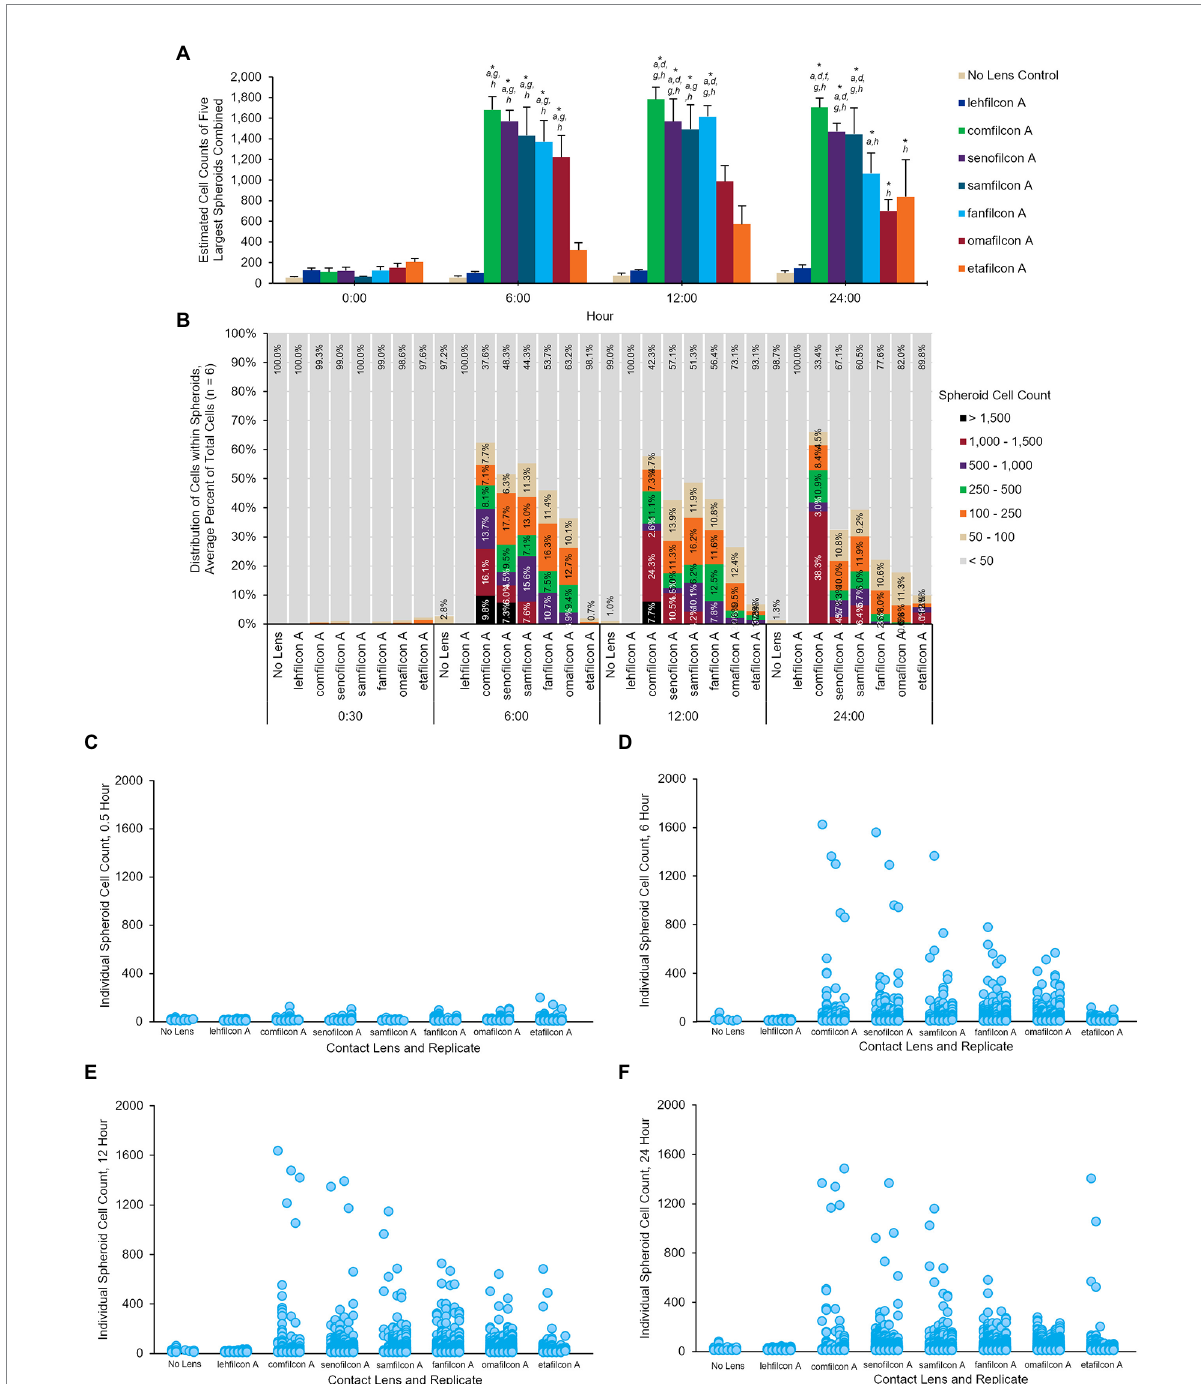
FIGURE 6 Once aggregated, cell counts of Acanthamoeba polyphaga (ATCC 30461) spheroids are maintained through 24 h. (A) Cell count of five largest spheroids on any one lens combined, calculated per lens type and presented at mean ± SE among 6 replicates. (B) Percentage of cells that are maintained in spheroids of various sizes over time, delineated by color for each spheroid size. Percentages are an average from 6 replicates per lens material. (C–F) Individual spheroid cell counts at the 0.5 h, 6 h, 12 h, and 24 h timepoints. Each individual spheroid on any lens, replicate, and timepoint is represented by a dot corresponding to its cell count. Replicates are visualized from left to right for each lens material ( n = 6). Time 0 baseline is calculated from the 0.5 h to allow cells to adhere to the material. Analyzed via two-way repeat measure ANOVA. Within a given timepoint: (a) p < 0.05 vs. lehfilcon A, (b) p < 0.05 vs. comfilcon A, (c) p < 0.05 vs. senofilcon A, (d) p < 0.05 vs. omafilcon A, (e) p < 0.05 vs. samfilcon A, (f) p < 0.05 vs. fanfilcon A, (g) p < 0.05 vs. etafilcon A, (h) p < 0.05 vs. No Lens Control. Within a given lens type, * p < 0.05 baseline (0.5